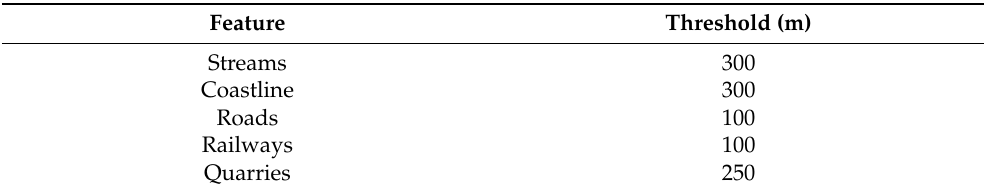
Table 2. Distance threshold for the predictor